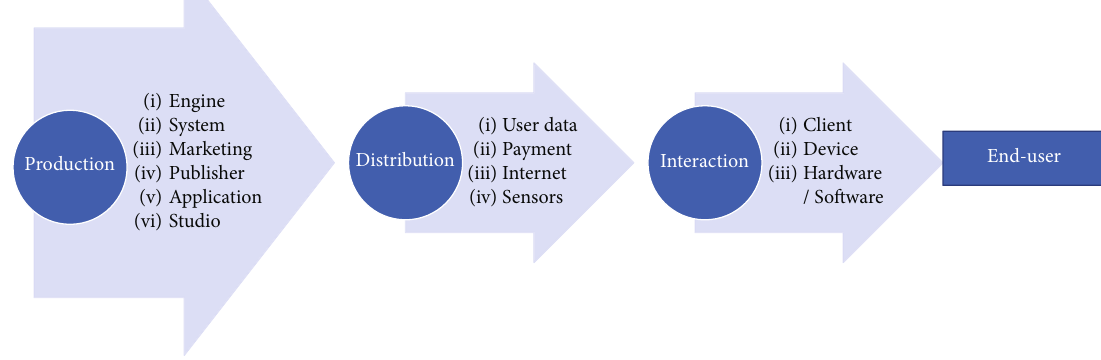
Figure 1: Mobile game